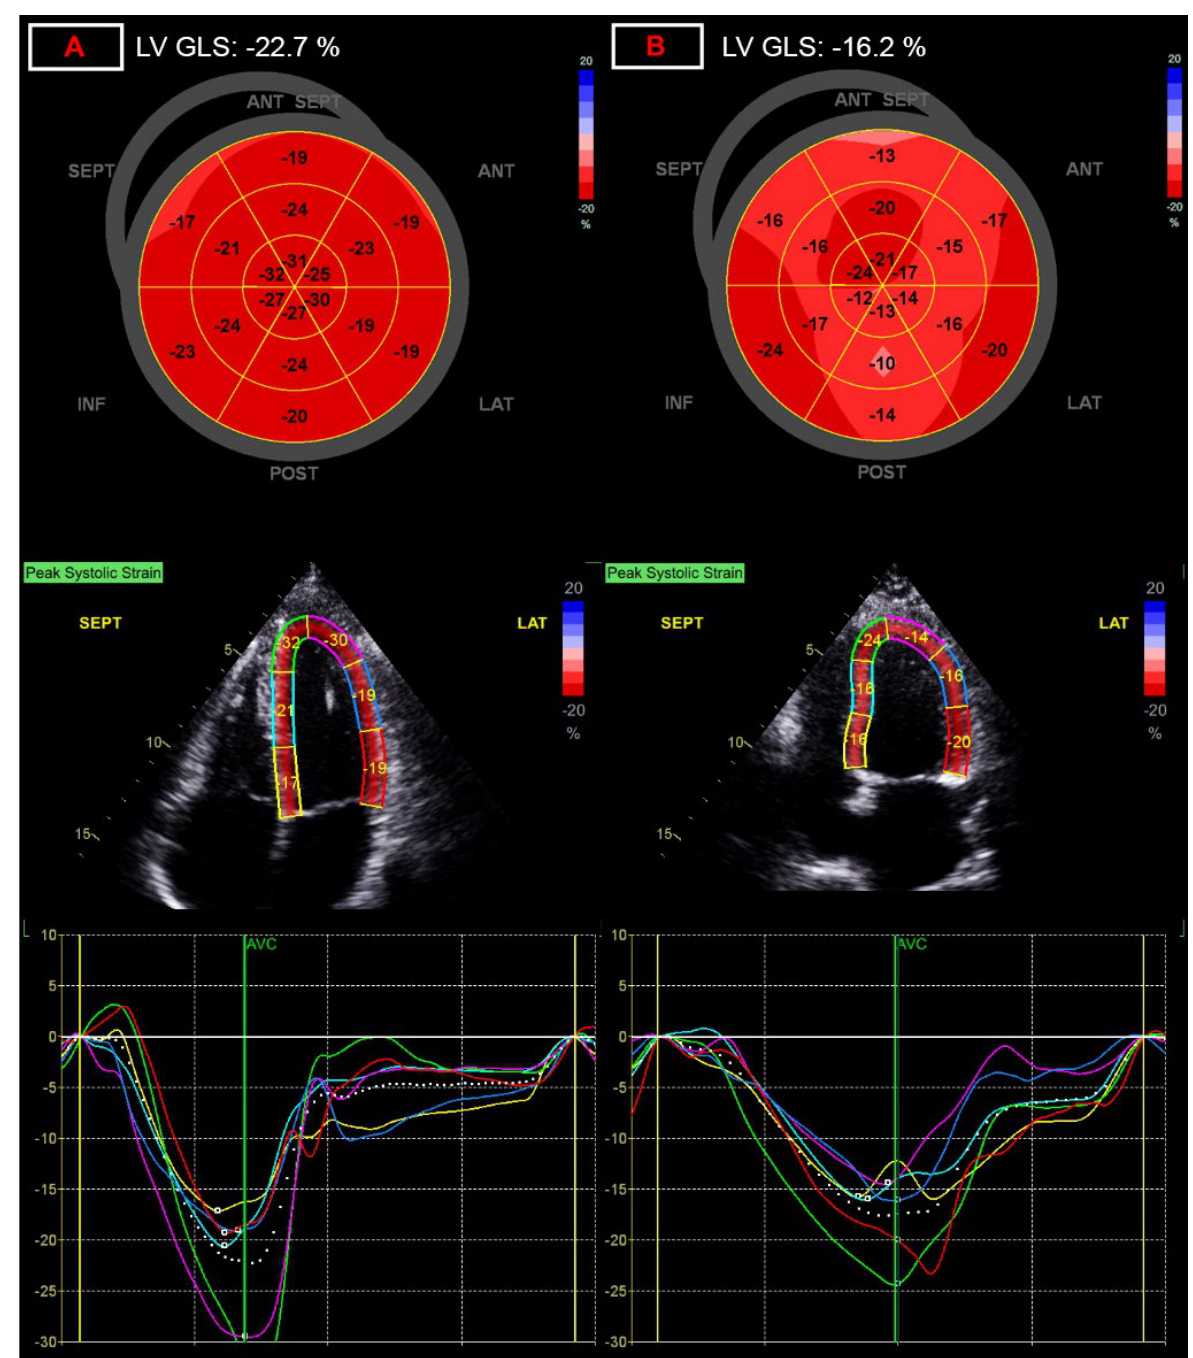
Figure 1. Representation of alterations of global longitudinal strain (GLS) measurement. ( A ) panel: normal left ventricular global longitudinal strain of −22.7%; ( B ) panel: decreased left ventricular global longitudinal strain of −16.2%, after COVID -19 infection.